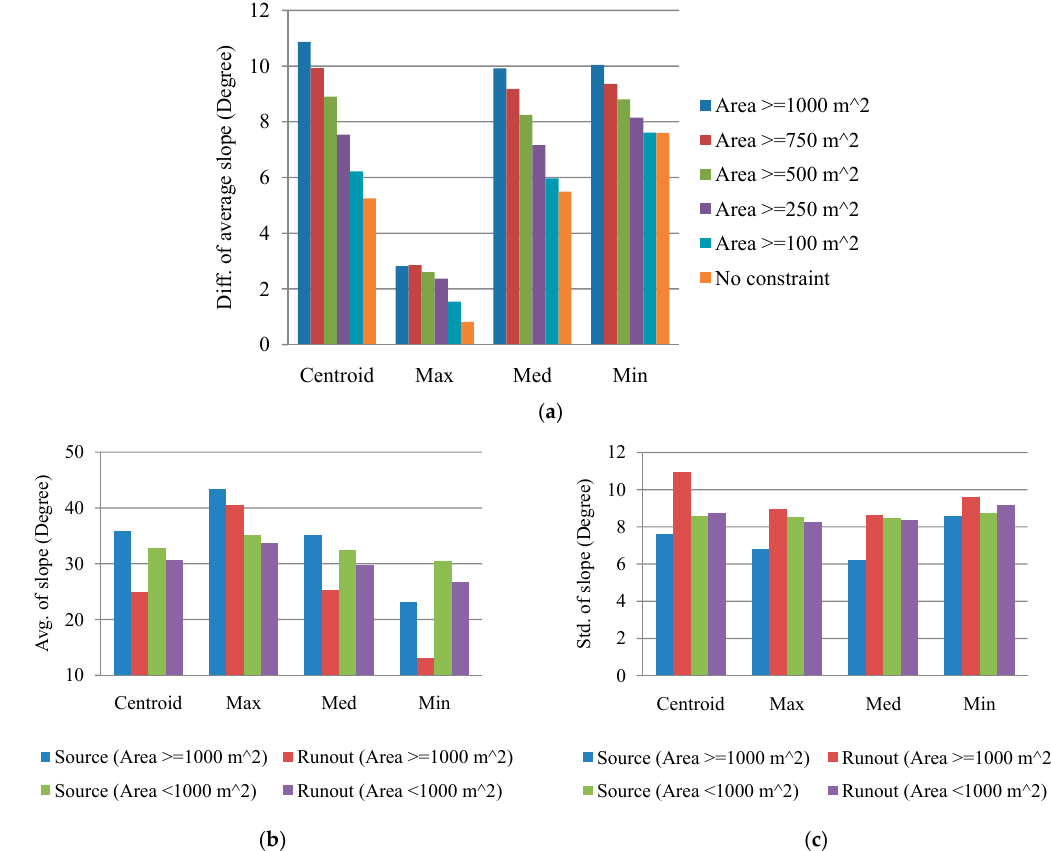
Figure 5. Slope distributions between the source and run-out areas using different sampling operators: ( a ) Difference in the average slope according to subtracting the run-out area from the source region in consideration of area constraints, ( b ) average slope of the area size of ≥ and <1000 m 2 , ( c ) standard deviation of (b).